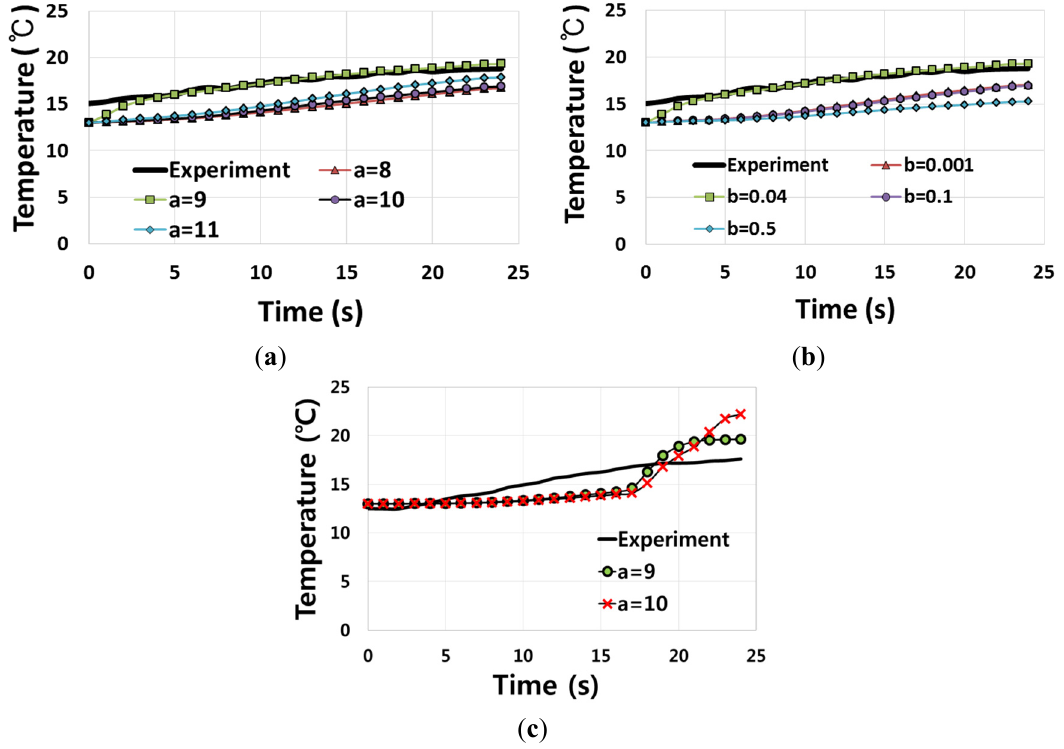
Figure 7. Temperature comparison between finite element predictions and experimental measurement ( a ) at TP1 when a varies with b =0.04 fixed, ( b ) at TP1 when b varies with a = 9.0 fixed, and ( c ) at TP3 when ( a , b ) = (9.0, 0.04) and ( a , b ) = (10.0,